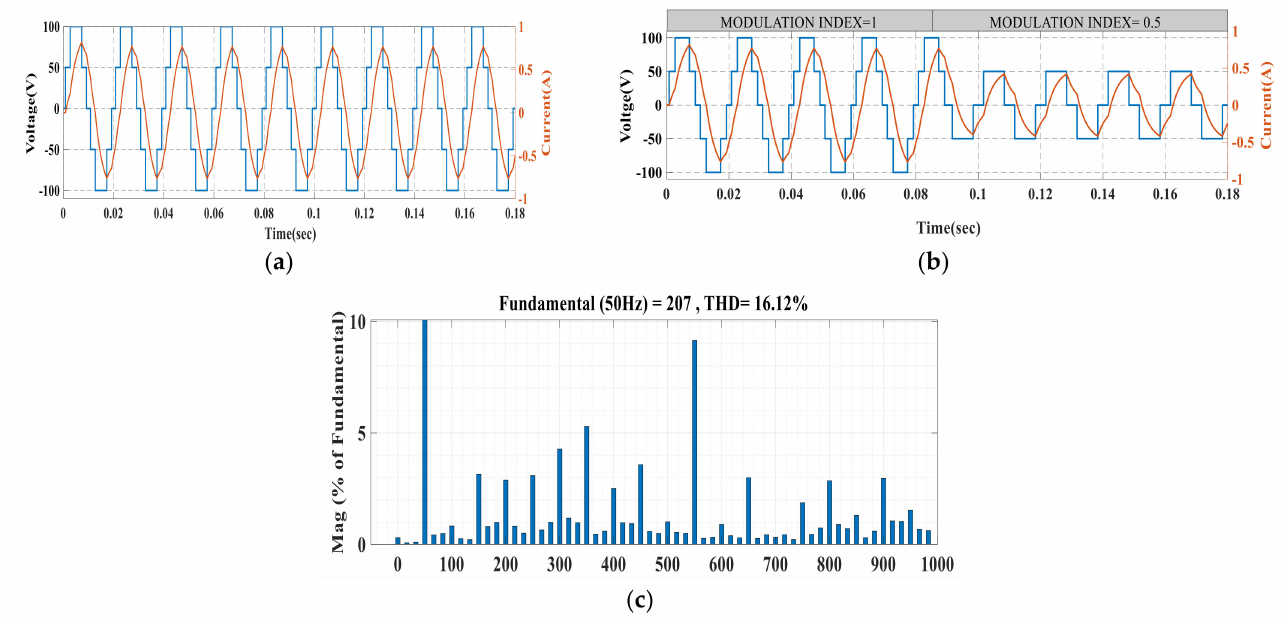
Figure 8. ( a ) Simulation results for output voltage and load current during normal condition, ( b ) output voltage and load current at modulation index 1 and 0.5, and ( c ) THD of voltage during normal